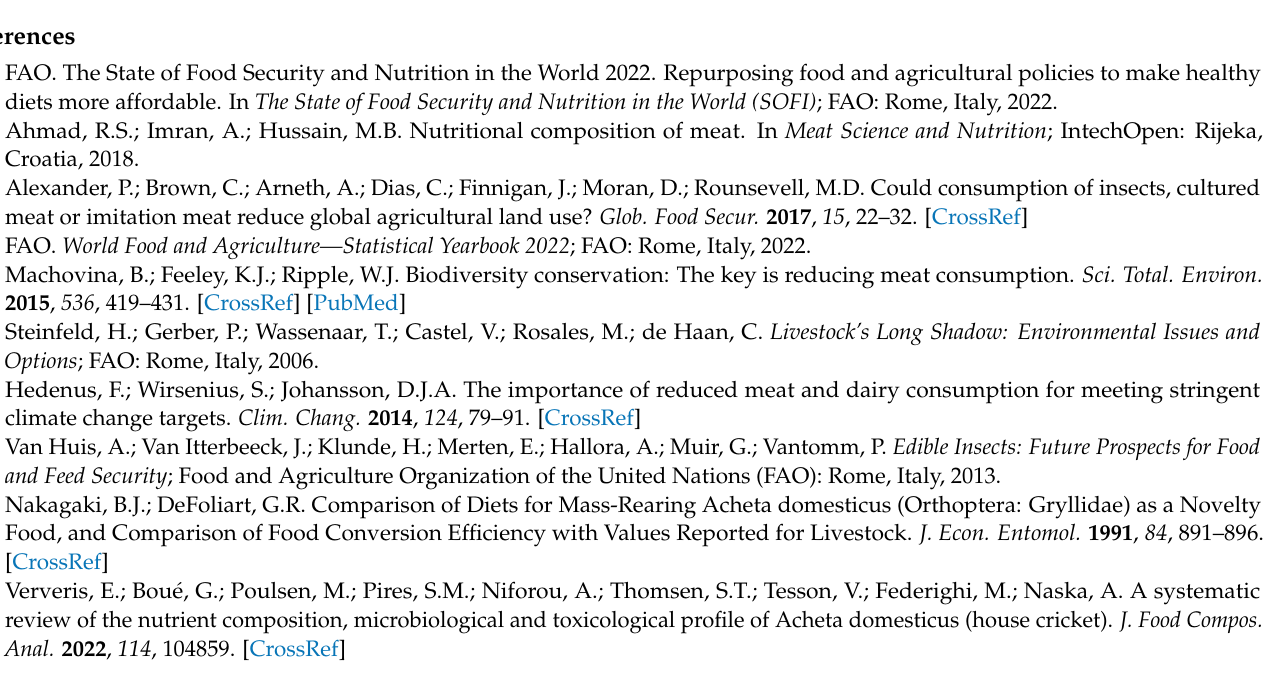
color; Figure S2: Fatty acid composition of cricket flour, bar chart; Table S1: Visual observation of gelation of cricket flour in water and NaCl solutions; Table S2: Fatty acid composition of cricket flour,